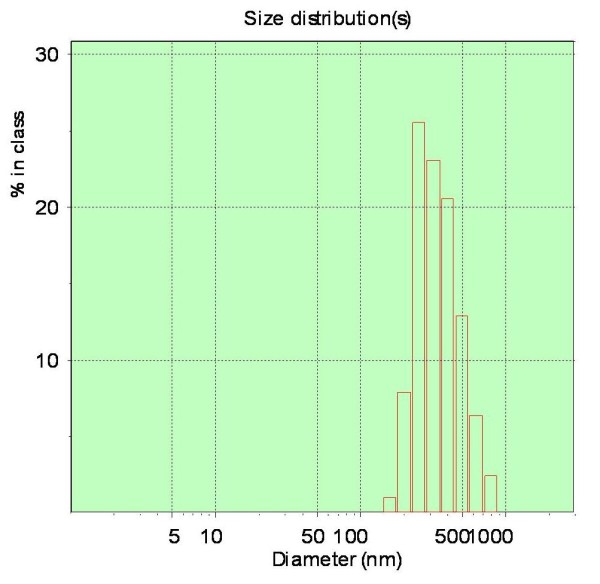
The DLS spectrum of C60dispersion.